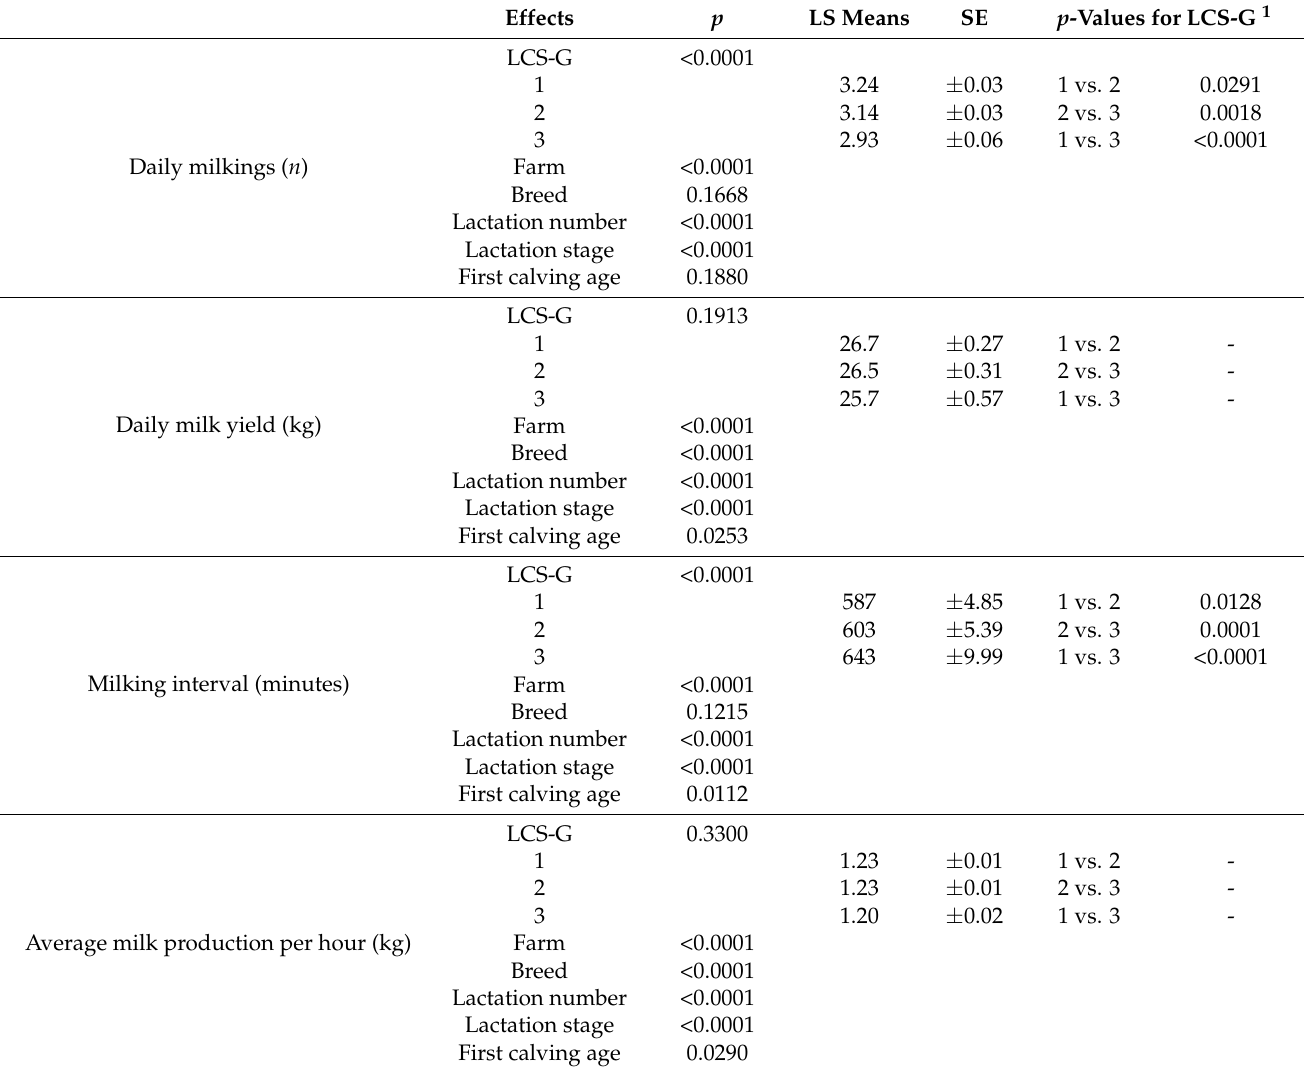
Table 7. Detailed results for parameters derived from AMS data according to LCS groups; LCS-G 1–3: locomotion score groups 1 to